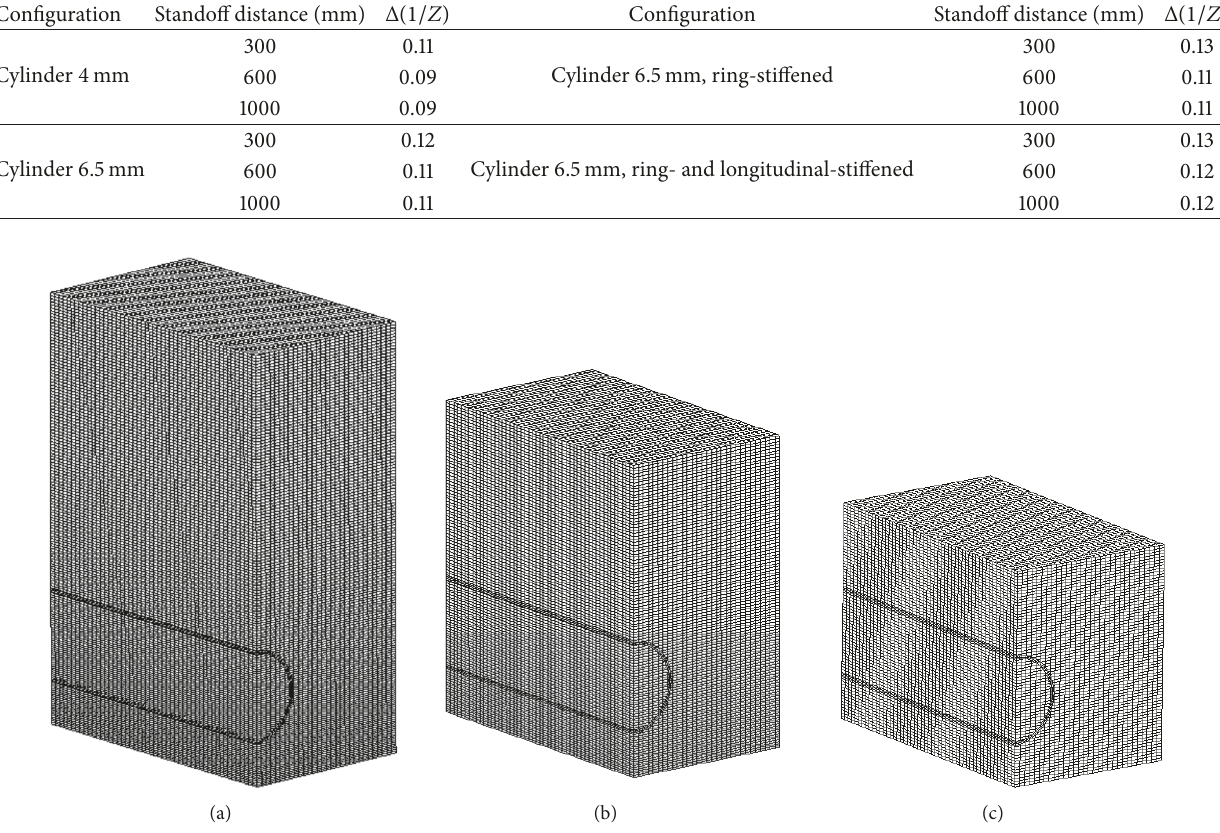
explosive is calculated, and according to the depth parameter, the internal energy of water is evaluated by means of